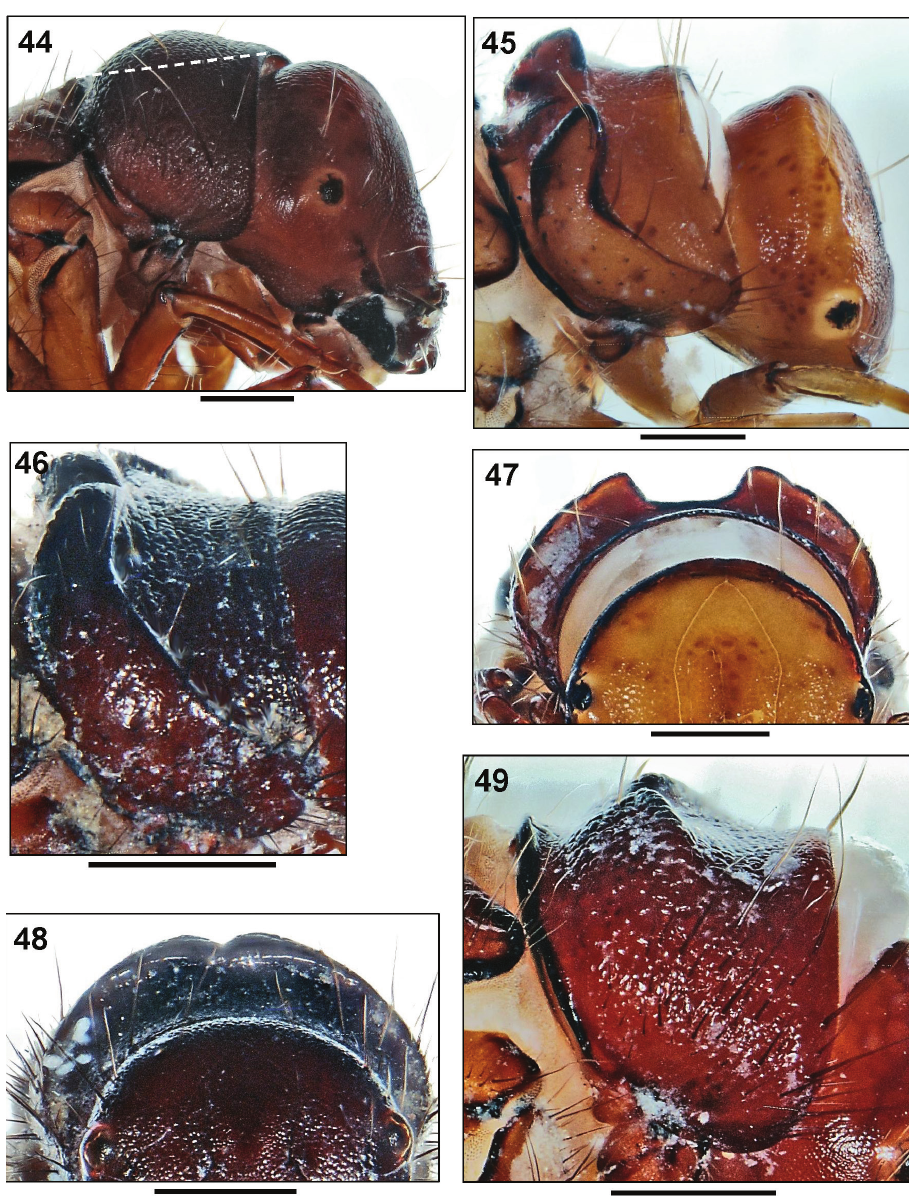
(Pictet, 1834) (dotted line: base of high pronotal hump) 45 Drusus bolivari (McLachlan, 1880) 46 Drusus chauvinianus (Stein, 1874) (= Anomalopterygella chauviniana (Stein, 1874). 47–48. Heads and pronota of 5 th instar larvae, frontal views. 47 Drusus bolivari (McLachlan, 1880) 48 Drusus chauvinianus (Stein, 1874) (= Anomalopterygella chauviniana (Stein, 1874). 49 Drusus ramae Marinkovic-Gospodnetic, 1971, 5 th instar larva, pronotum, right lateral view. Scale bars: 0.5